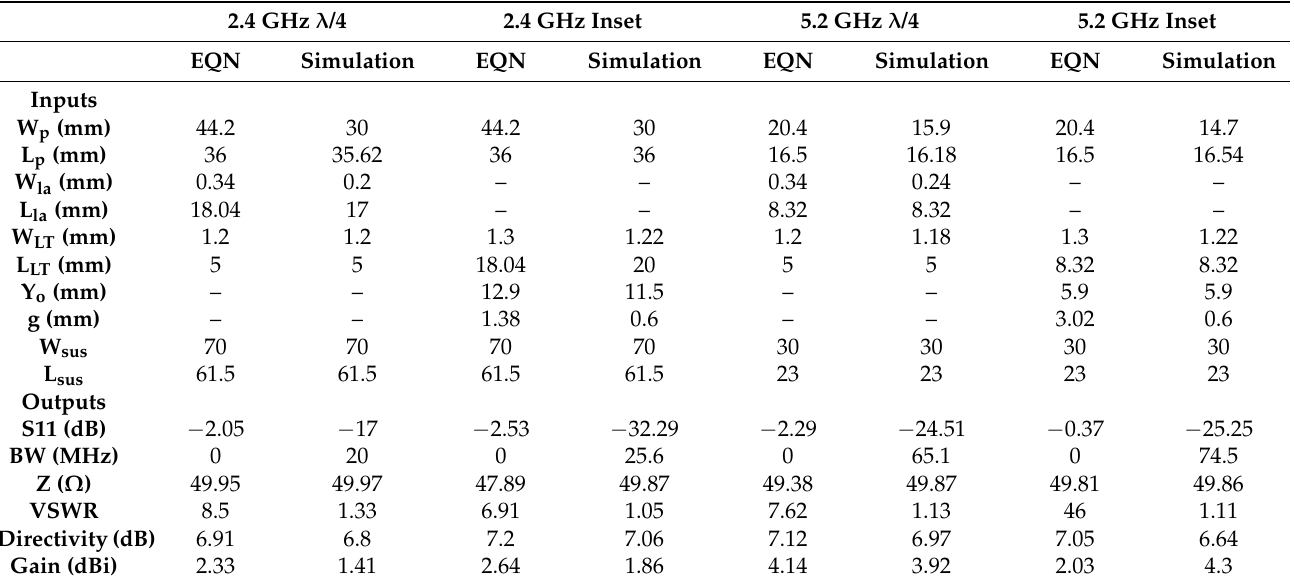
Figure 18. ( a ) Directivity and ( b ) gain ( right ) of new design of patch antenna of 2.4 GHz with line transmission λ /4. Table 9. Inputs and outputs of the calculated and simulated parameters of the